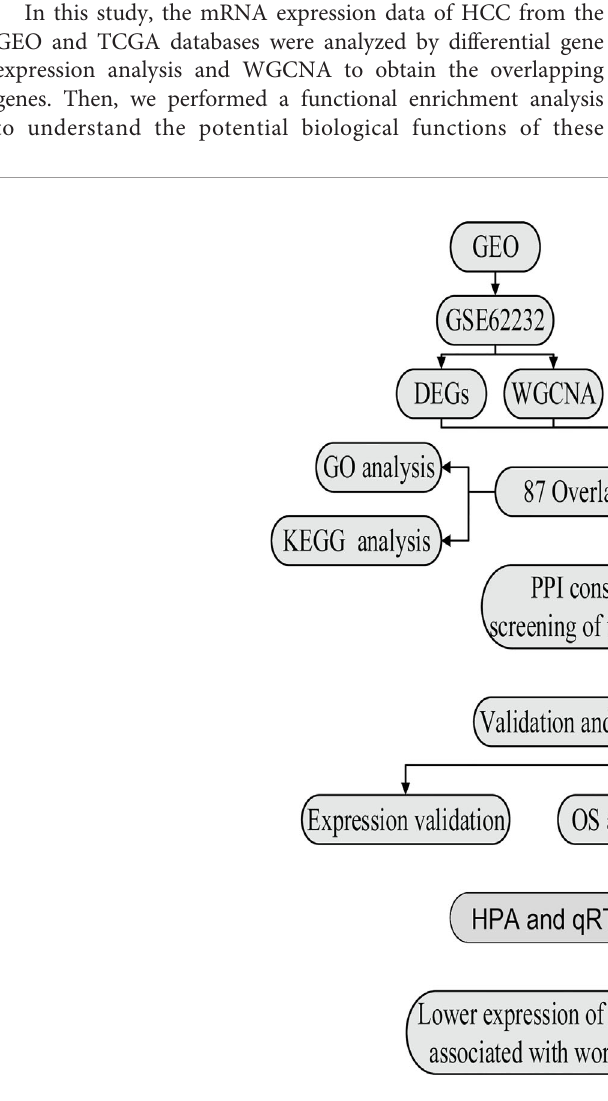
FIGURE 1 | The fl ow chart of data preparation, processing, analysis, and